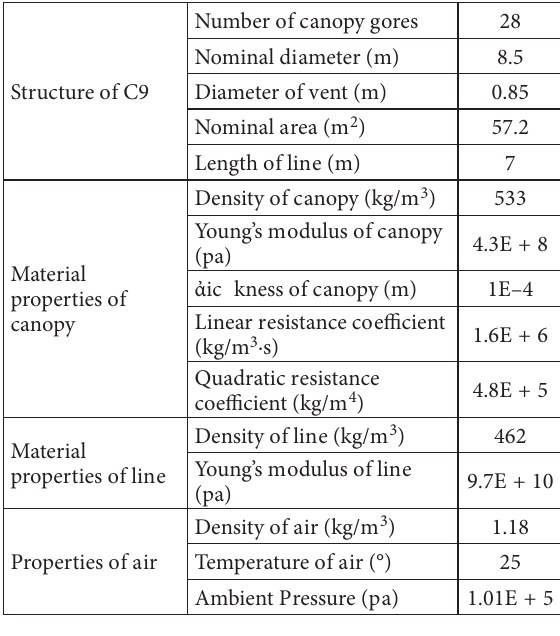
Table 1. Parameters of